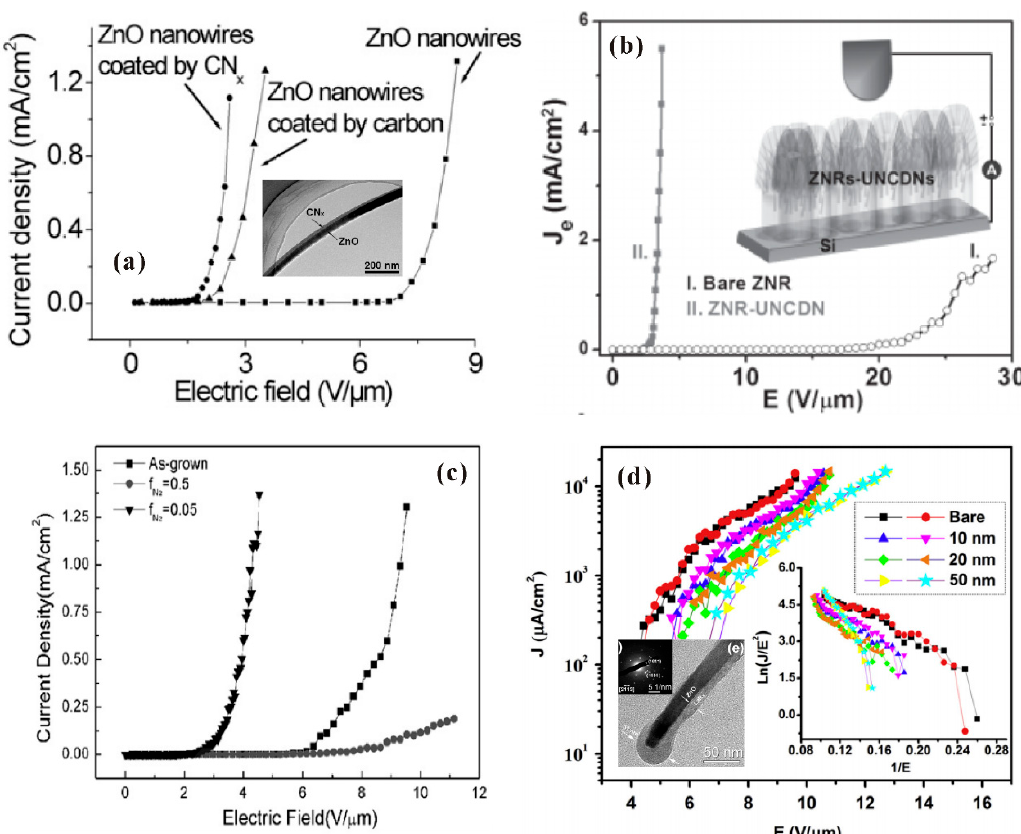
Figure 23. Field emission characteristics of ZnO nanostructures with or without coating. ( a ) Results for ZnO nanowires, ZnO nanowires coated with carbon or CNx. Reproduced from [92], with the permission of IOP Publishing, 2005. ( b ) Results for ZnO nanorods and ZnO nanorods coated with UNCDN. Reproduced from [93], with the permission of John Wiley and Sons, 2013. ( c ) Results for ZnO nanorods and HfN x coated ZnO nanorods. Reproduced from [94], with the permission of Elsevier, 2008. ( d ) Results for bare and different thickness LaB 6 coated ZnO nanowires. Reproduced from [95], with the permission of Elsevier, 2013.